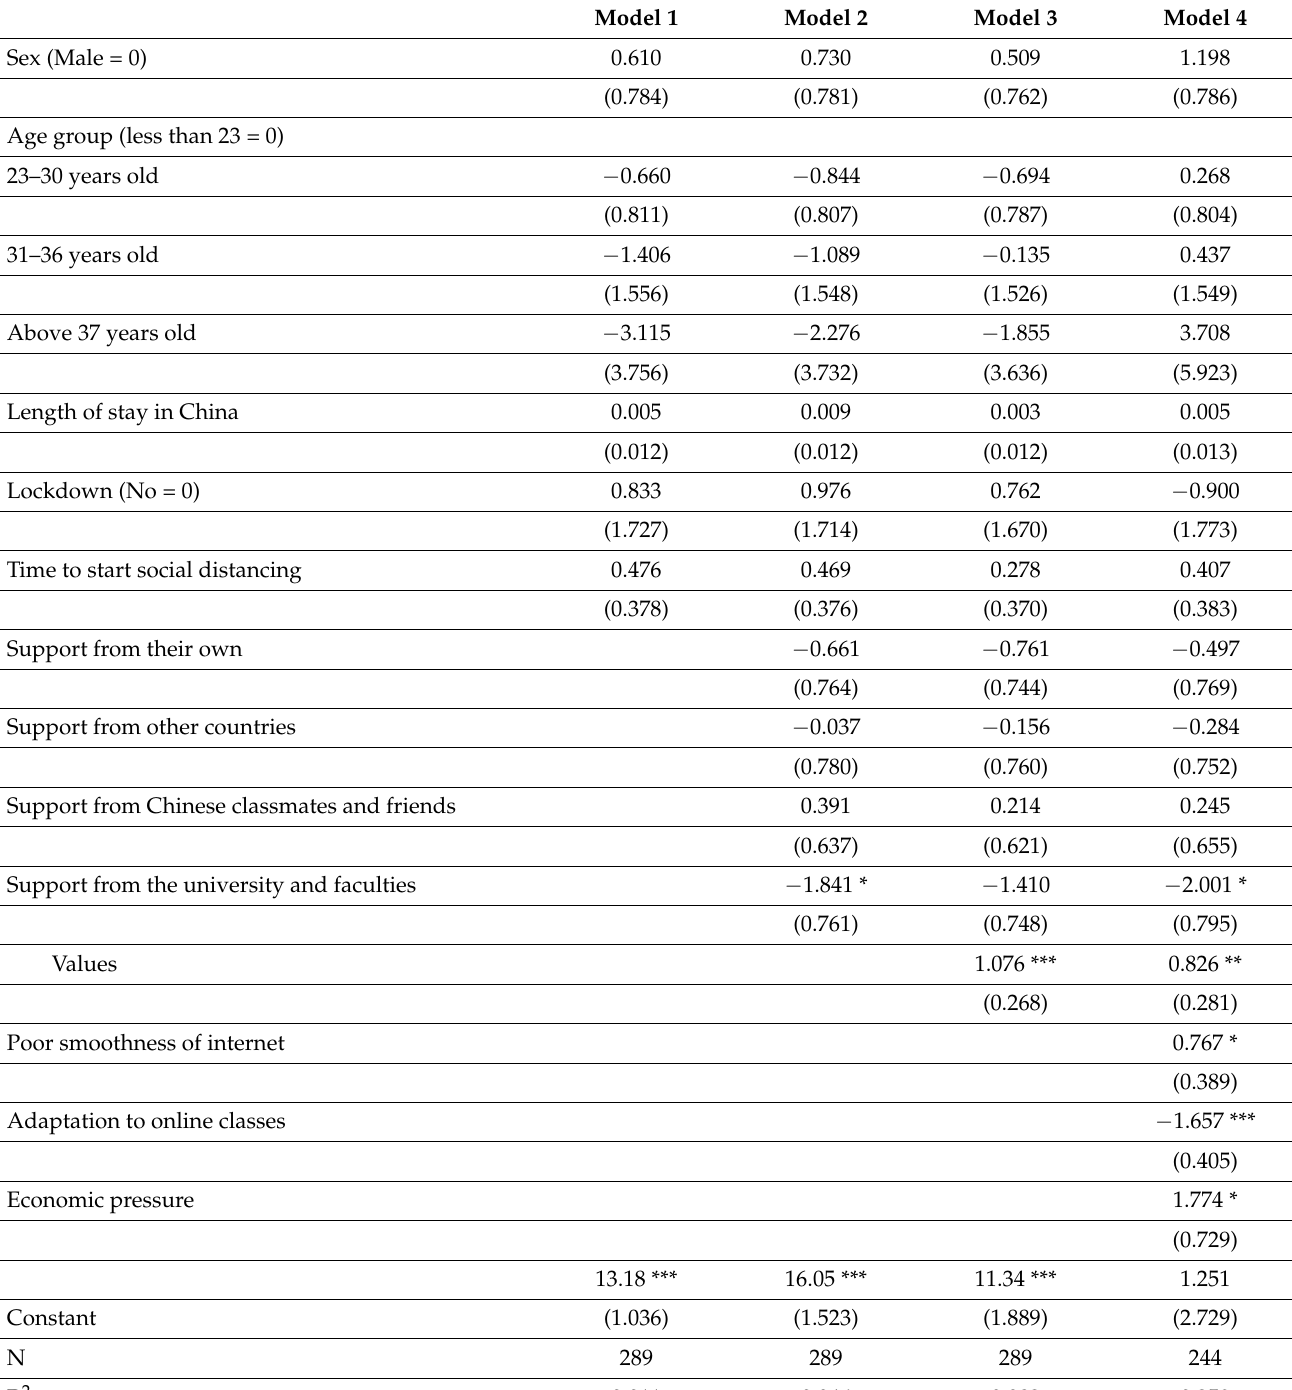
Table 3. Regression model of lockdown, social support, and learning behavior